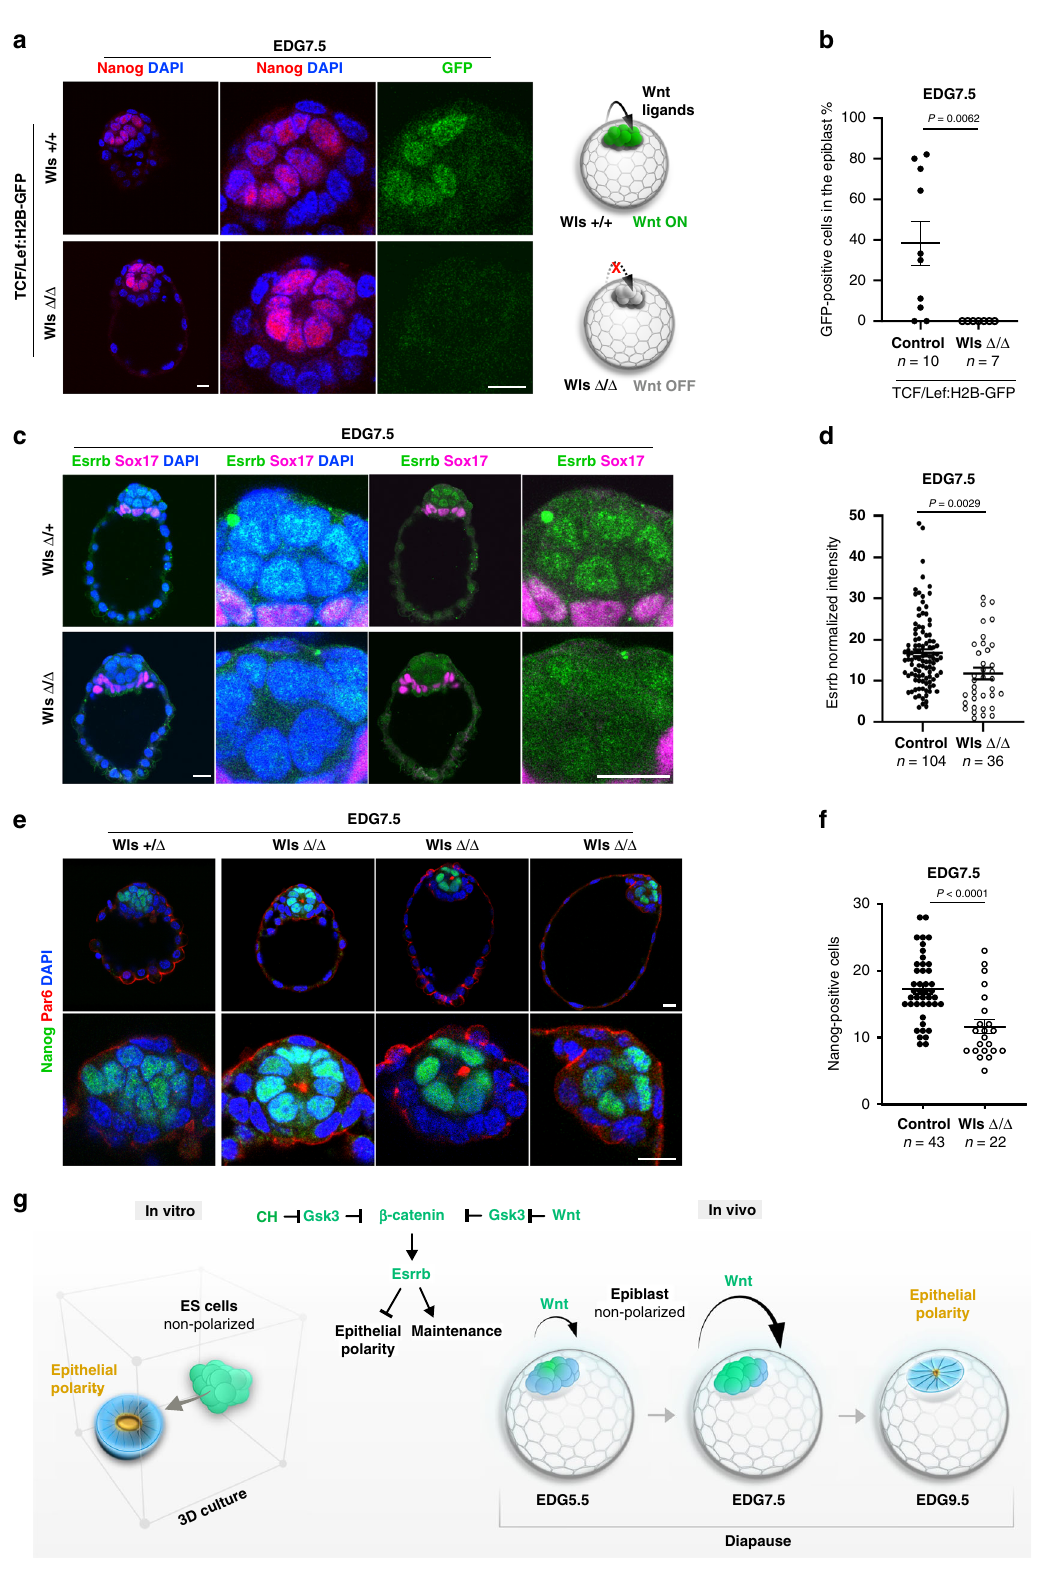
mechanisms that can appear redundant during transient embryonic development. Future research can reveal to what extent cell signalling and tissue organisation principles in the epiblast are shared in other mammalian species that utilise dia- pause as a reproductive